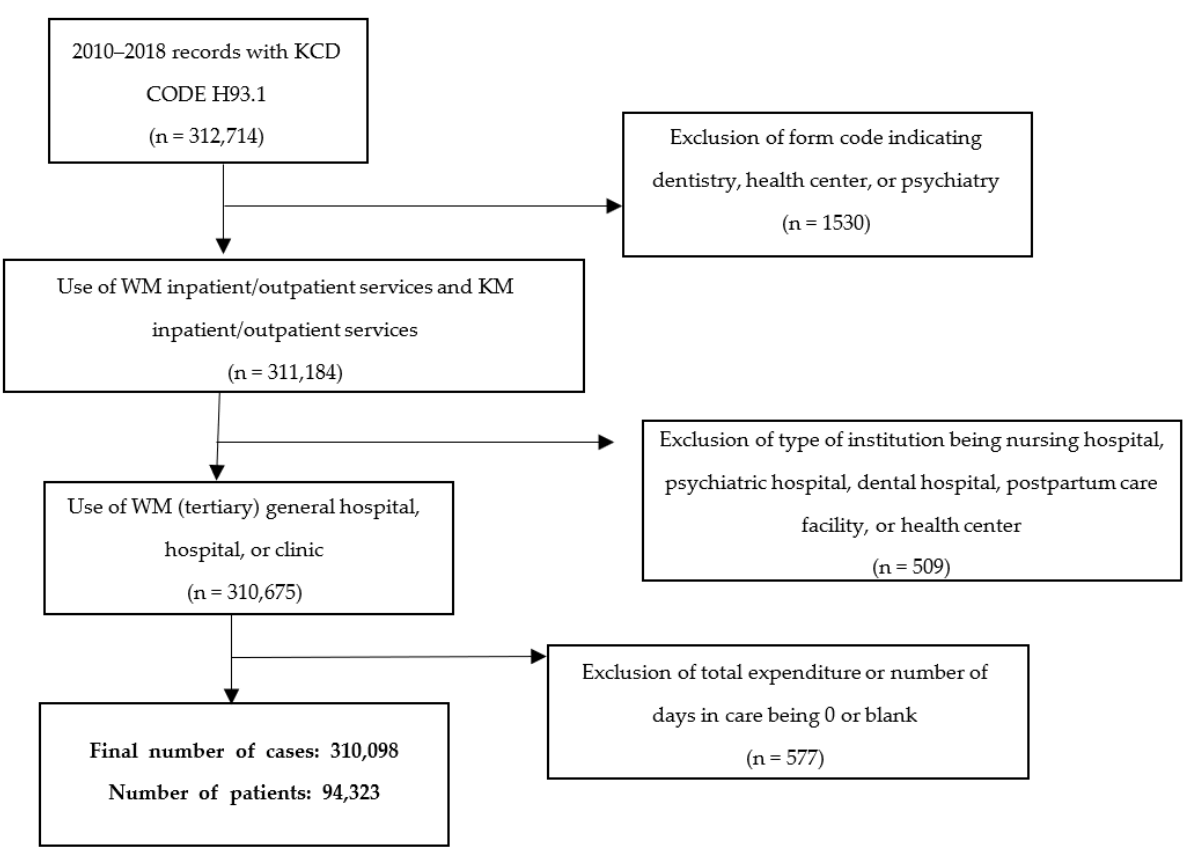
Figure 1. Flowchart of the study population selection process.